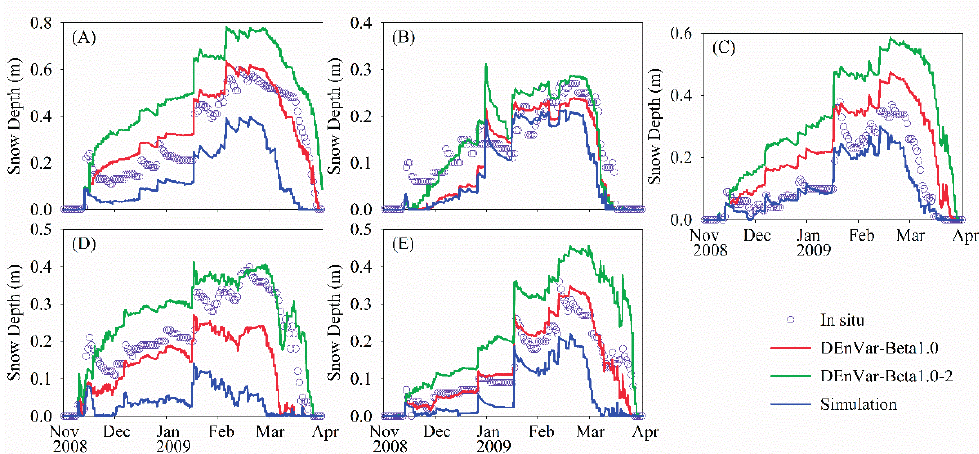
Figure 9. The SD time series of in situ SD observations and the analyzed SD in the DEnVar-Beta 1.0 and DEnVar-Beta 1.0–2 sensitivity tests at the ( A ) Aletai, ( B ) Buerjin, ( C ) Fuyun, ( D ) Jimunai, and ( E ) Qinghe sites. The observation standard errors ( σ obs ) at five sites in the DEnVar-Beta 1.0 experiment are given in Table 1. The DEnVar-Beta 1.0–2 experiment is the same as the DEnVar-Beta 1.0 experiment, but the MODIS SCF observation error is set to 10%.